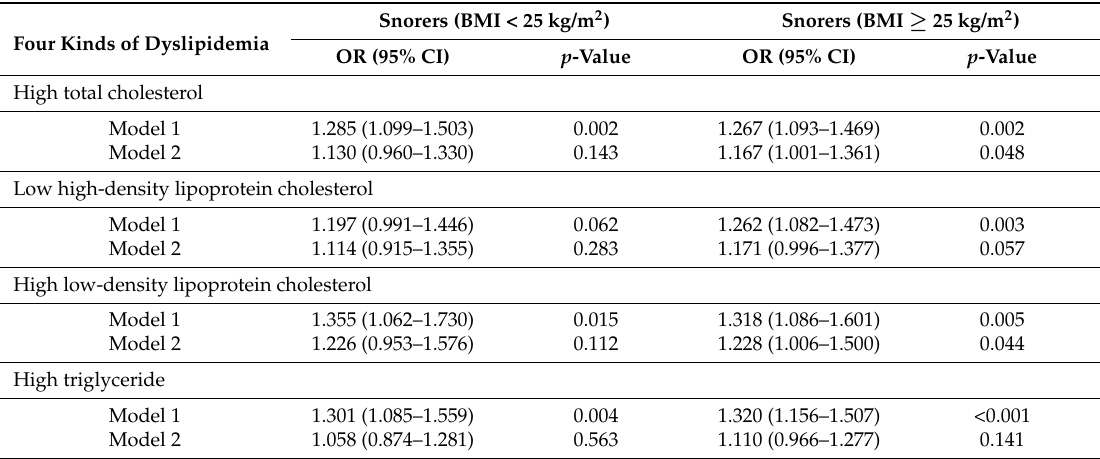
Table 3. Multiple regression analyses for the relationship between self-reported snoring and each kind of dyslipidemia according to participants with BMI < 25 kg/m 2 or BMI ≥ 25 kg/m 2 .